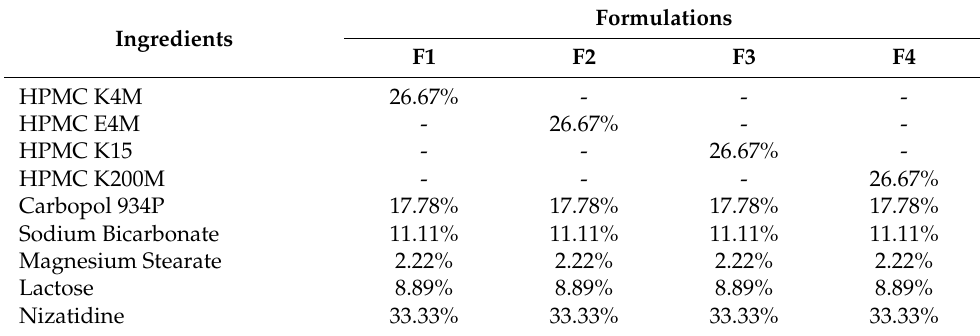
Table 1. Composition of nizatidine floating